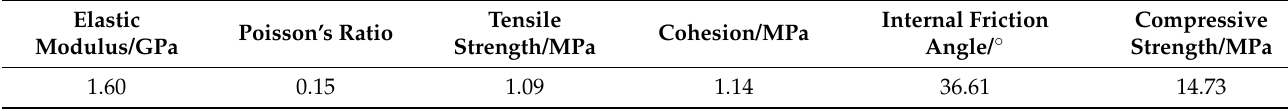
Table 2. Physical and mechanical parameters of the experimental coal sample.